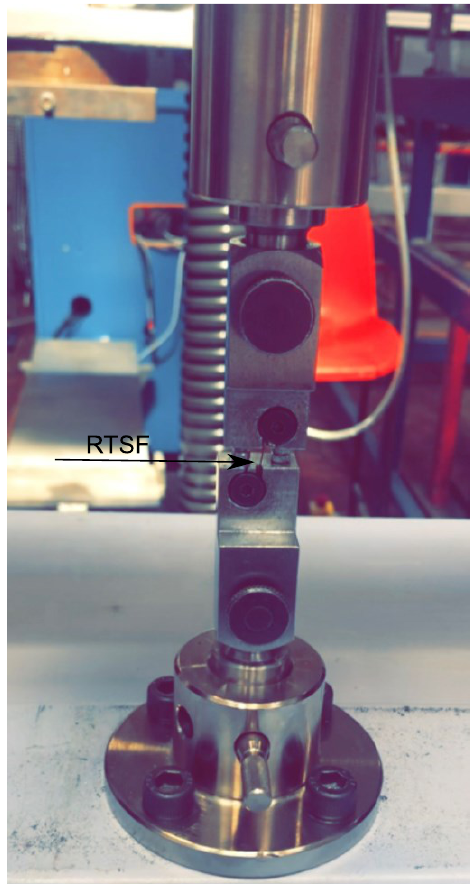
Figure 5. Set-up for tensile testing of RTSF.